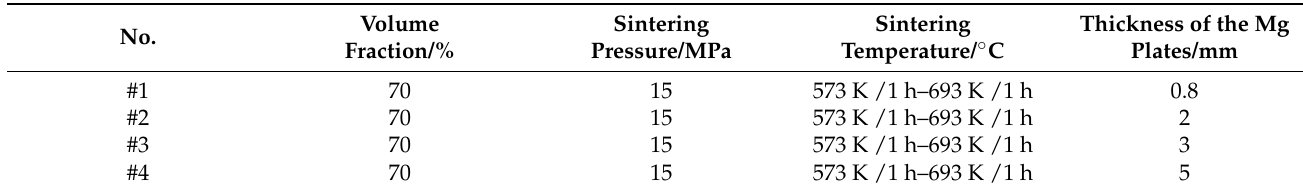
Table 4. Preparation of the sandwiched magnesium matrix syntactic foams.